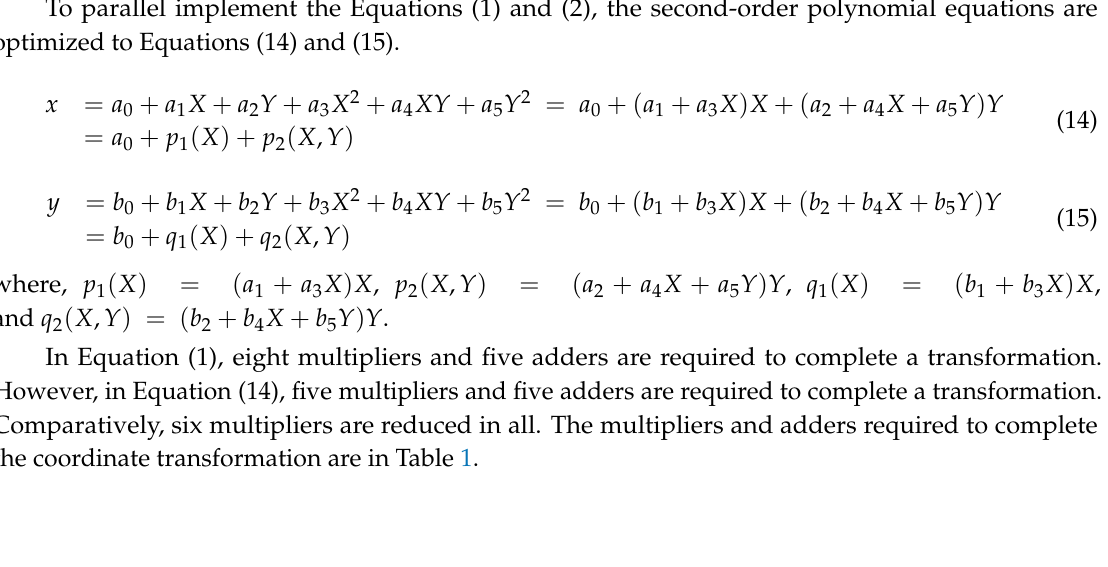
Table 1. The number of multiplier and adder comparison with Equation (1), (2), (14), and (15) Coordinate Traditional 2nd polynomial Optimized 2nd polynomial Reduce Multiplier Adder Multiplier Adder Multiplier